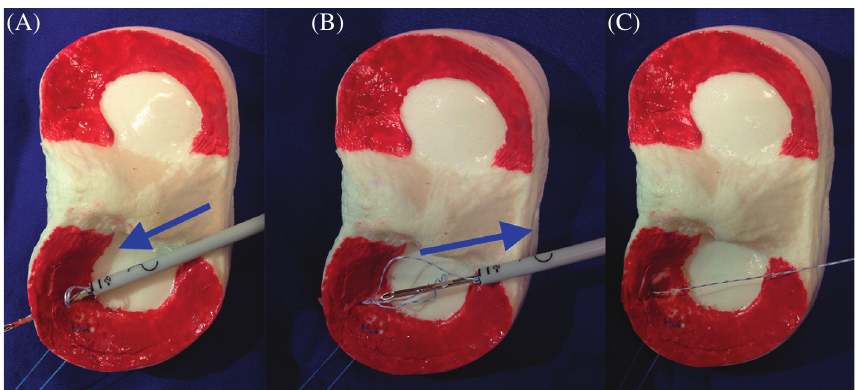
Figure 3. Application of the second all-inside suture in our hybrid technique. (A) Insertion of the suture. (B) The unfixed suture will easily come off as the hand instrument is being removed. (C) The reduced meniscus can easily be